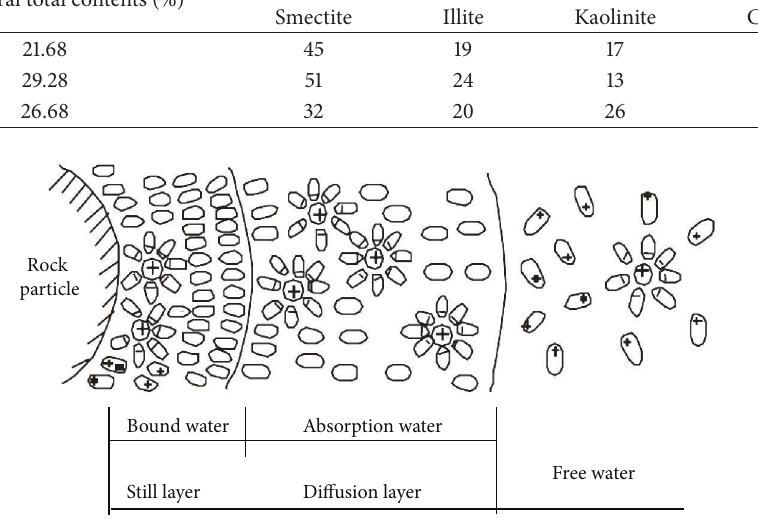
Table 1: Clay mineral contents and water diffusion coefficient of shale. Core no.